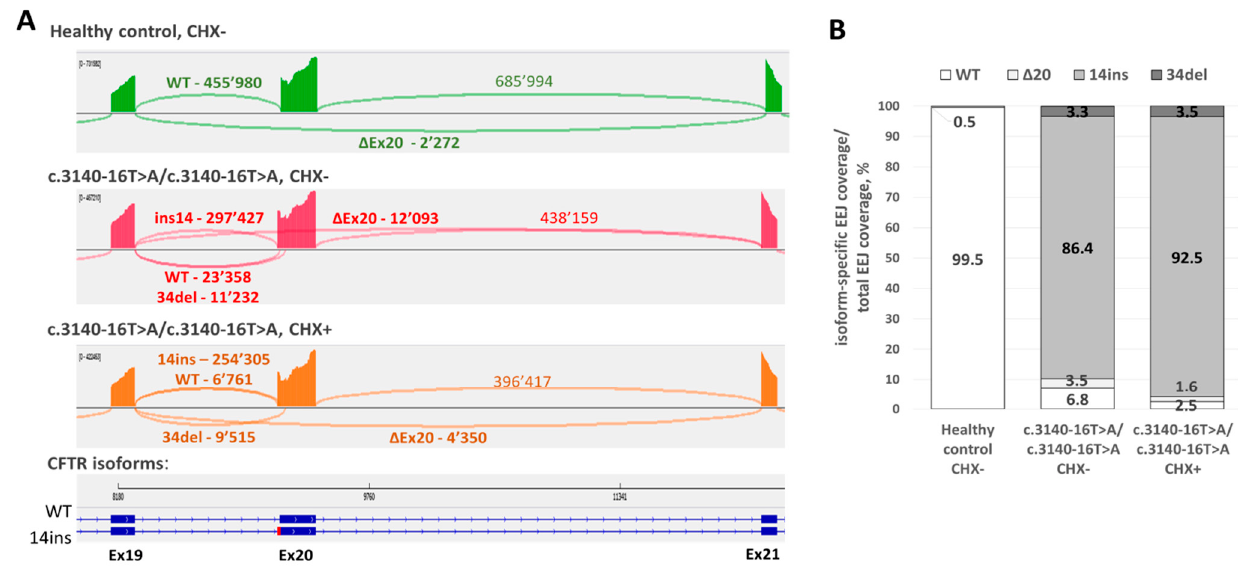
Figure 6. Targeted next generation sequencing of PCR-products covering CFTR exons 18–22 and obtained from intestinal organoid samples of healthy control and c.3140-16T>A homozygous patient before (CHX-) and after (CHX+) NMD inhibition by 300 µ M cycloheximide treatment. ( A ) Sashimi plots to visualize splice junctions in different samples. Numbers represent the number of reads spanning indicated exon/exon junction (EEJ). ( B ) The relative amount of each CFTR isoforms in samples are represented as percentage of isoform-specific EEJ-coverage from total EEJ